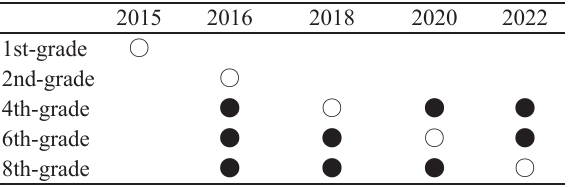
Figure 1. Target grade and survey schedule in